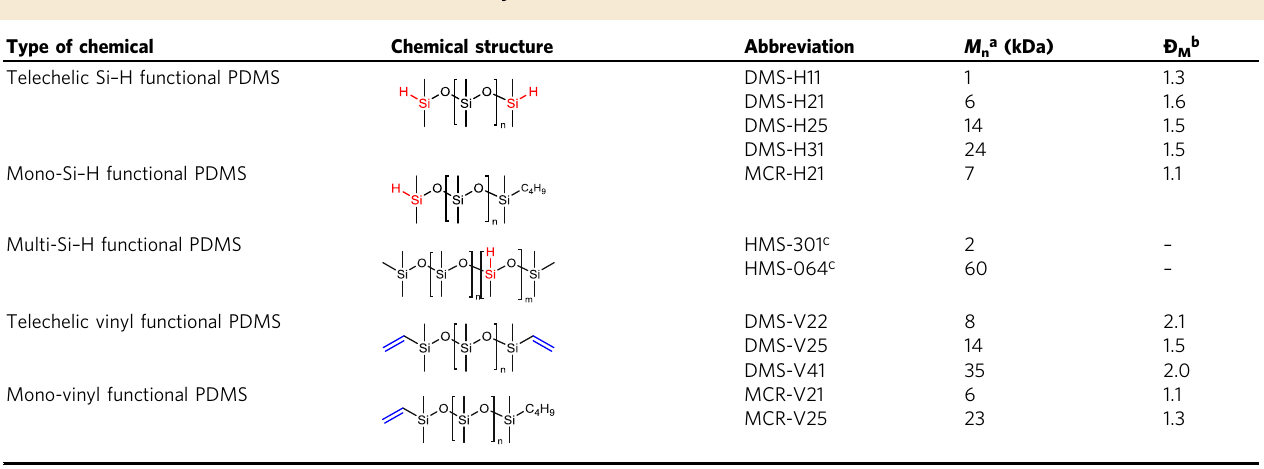
Table 4 Information of chemicals used in this